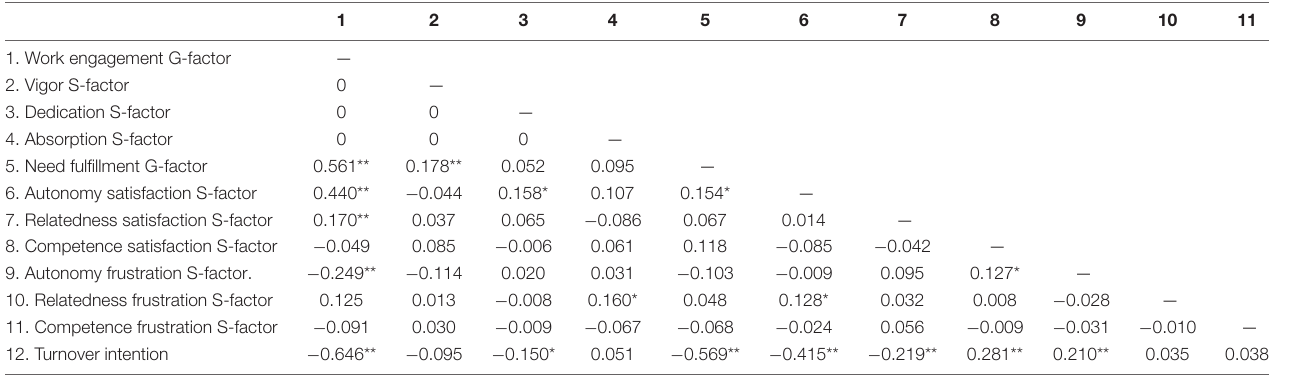
TABLE 3 | Spearman Bivariate correlations between the variables used in Sample 1 ( N = 242).